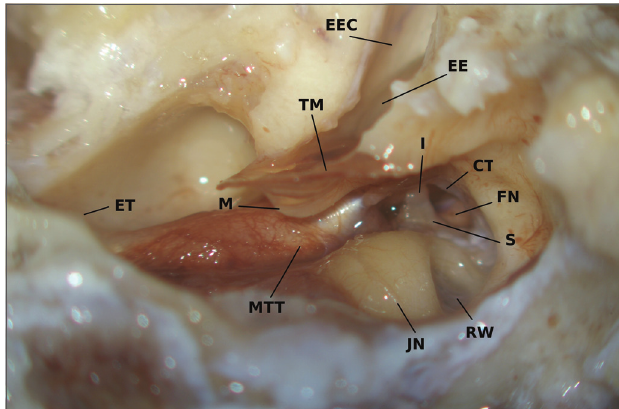
Figura 3. Anatomia do ouvido médio da ovelha (ouvido direito), visto a partir do hipotímpano aberto. O conduto auditivo externo (EEC) foi aberto para mensurações e exposição da extensão do epitimpânica (EE) da membrana timpânica. Pode-se também identificar a membrana timpânica (TM) com o cabo curvo do martelo (M). O músculo tensor do tímpano (MTT) se insere diretamente sobre o martelo com o corda do tímpano (CT) o circundando. O estribo (S) está circundado pelo nervo facial (FN) e ligado ao processo longo da bigorna (I). RW = janela redonda, JN = nervo de Jacobson, ET = abertura para a tuba